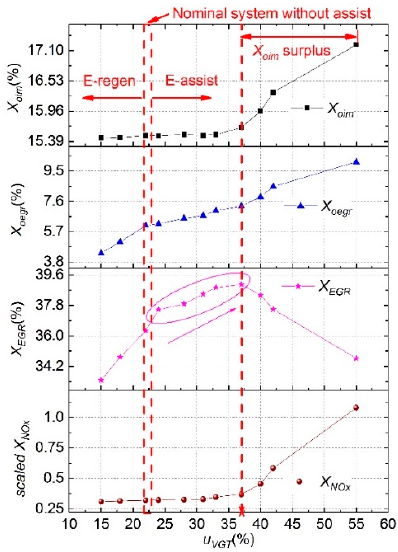
Figure 7. Comparison of three performance variables with NOx concentration.